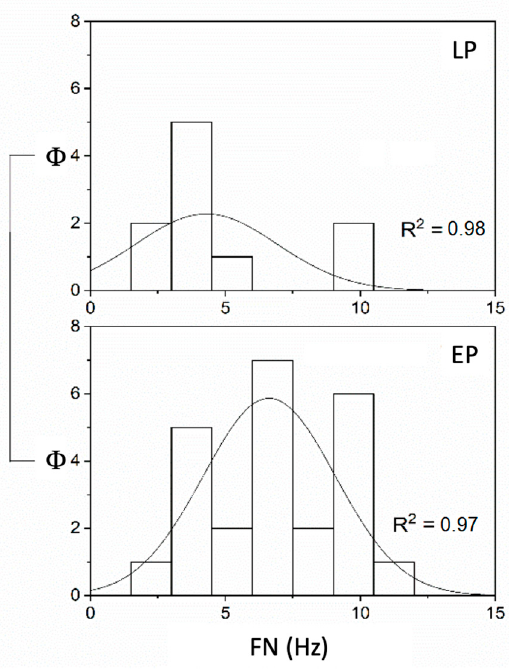
Figure 3. FN (Hz) in compensated (LT) and uncompensated (ET) UPVL patients with SVINT applied on the vertex ( Φ = data distribution frequency). The Gaussian peak represents the mean of SVIN frequency in Hz. Normal frequency distribution curve and fitting analysis, LT, R 2 = 0.98, while R 2 = 0.97 for ET ( p = 0.001).